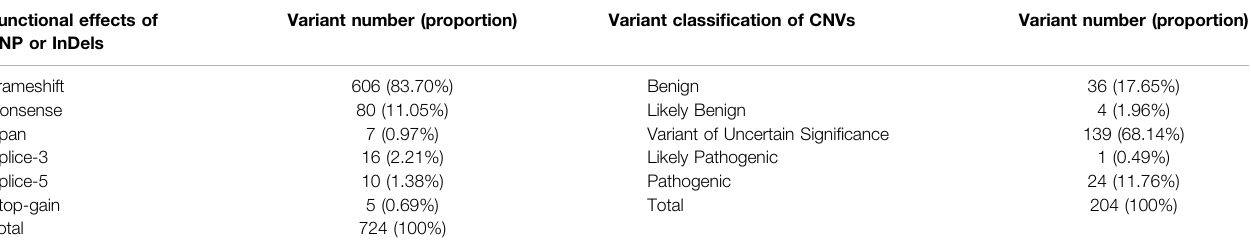
TABLE 2 | Functional effects of SNP or InDels and variant classi fi cation of